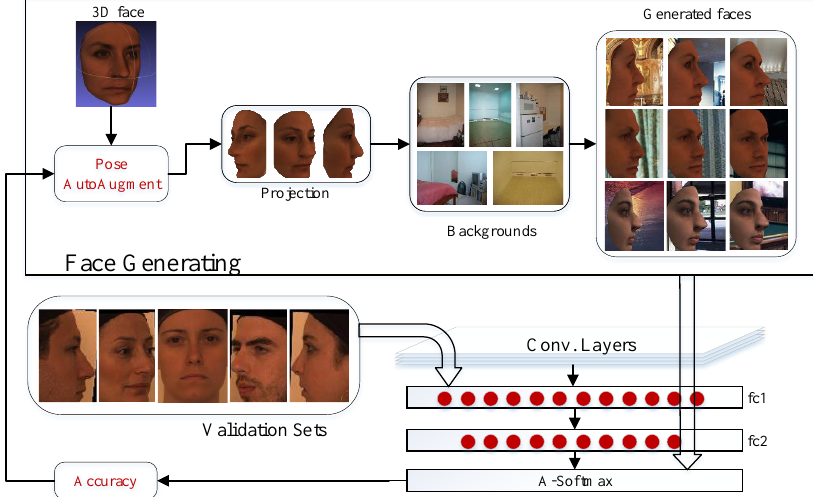
Figure 1. The framework of PAFR. First, we preprocess the face scan to obtain a smoothed face, then randomly render 2D faces by Pose AutoAugment. 2D synthetic faces are generated as training samples after projection, cropping, background appending. Third, we train an arbitrary-pose face recognition model. The controller model is updated by the validation